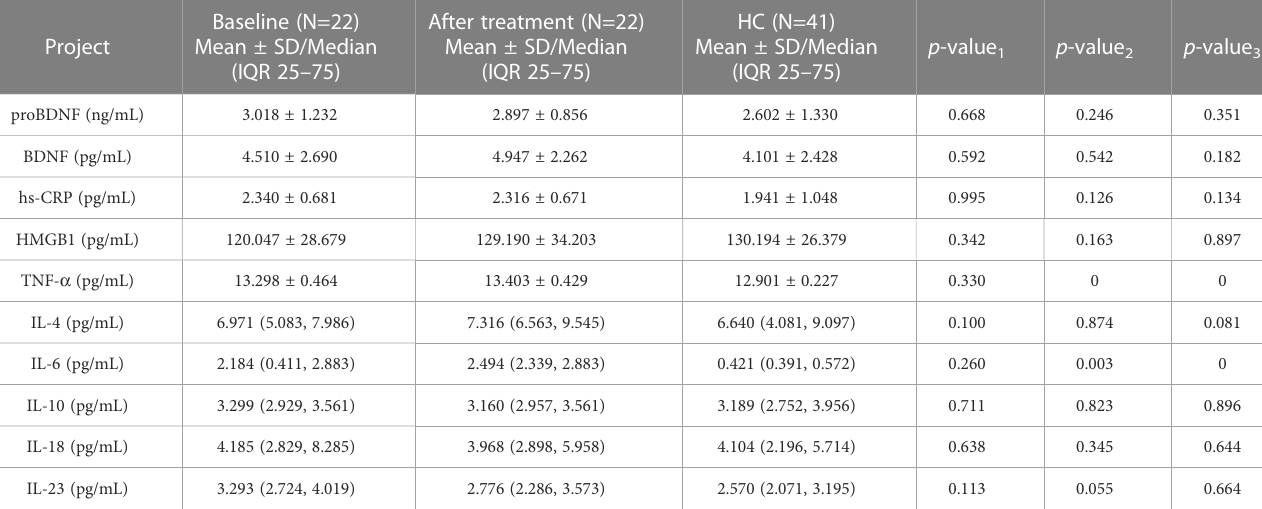
TABLE 3 Comparison of biomarkers baseline and after MDD treatment.